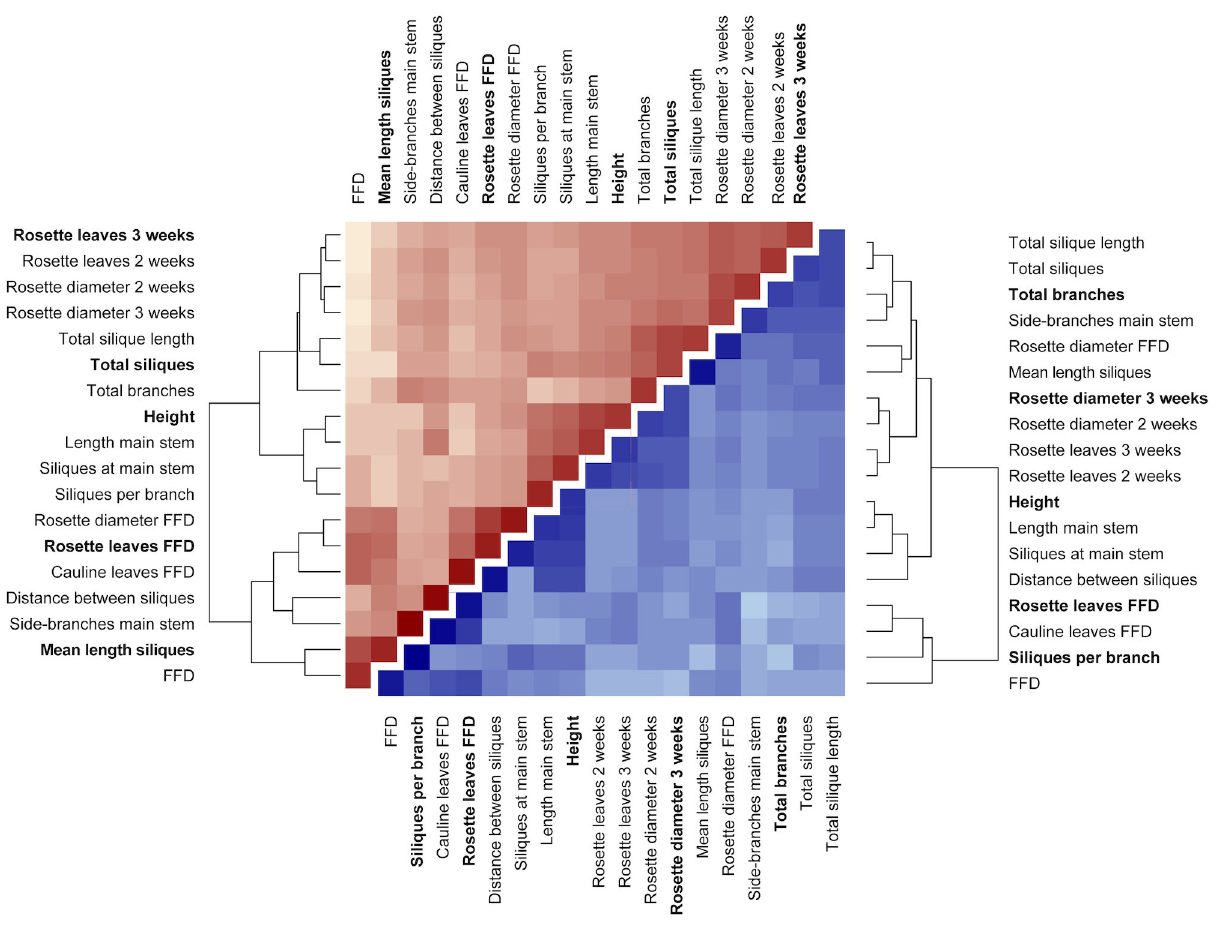
Figure 2. Correlation analysis to select a subset of independent phenotypic traits. The heat map shows pairwise Pearson correlations between phenotypic traits (darker colors denote stronger correlations), with data from the heat stress experiments above the diagonal in red and data from the salt stress experiment below the diagonal in blue. Phenotypic traits written in bold letters were selected for statistical